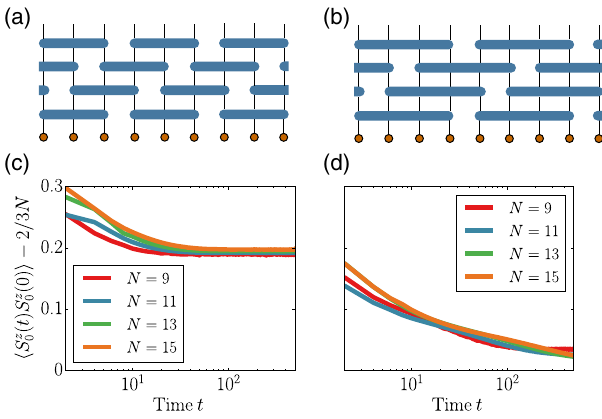
FIG. 10. Thermalization in charge- and dipole-conserving random circuit models. The two versions of the circuit, with (a) three-site and (b) four-site gates resemble the Hamiltonians H H H 3 and 3 þ 4 , respectively. Consequently, (c) the autocorre- lator obtained for the three-site circuit has a finite long-time value, while (d) in the four-site circuit it slowly decays to zero. The curves correspond to the infinite temperature correlator, averaged over 50 random state and circuit realizations for N ≤ 13 and 20 realizations of N ¼ 15